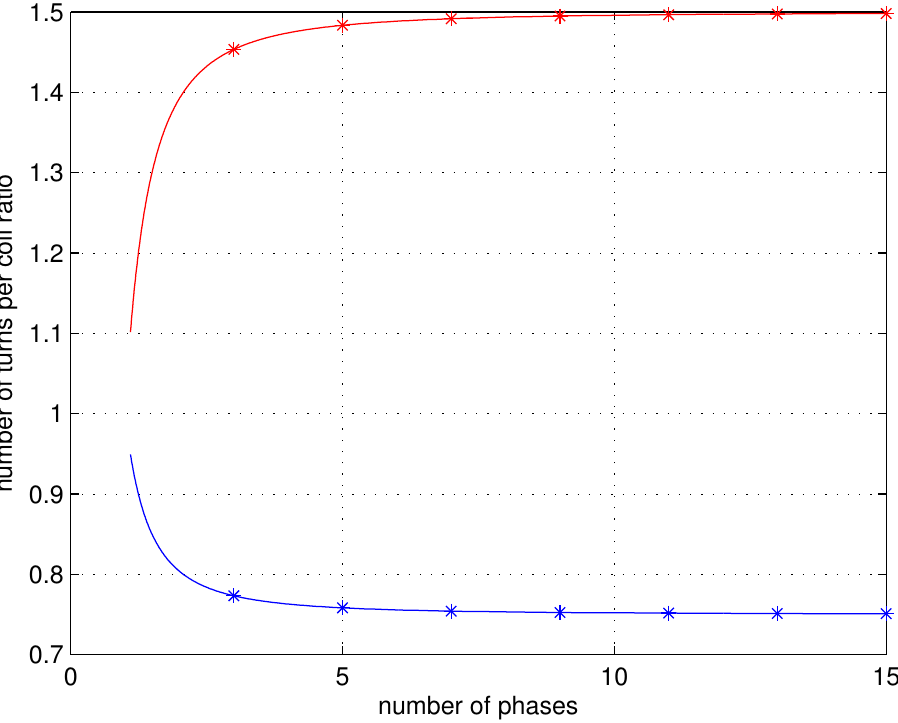
Figure 7. Number of turns per coil ratio versus the number of phases q . Legend: (red)